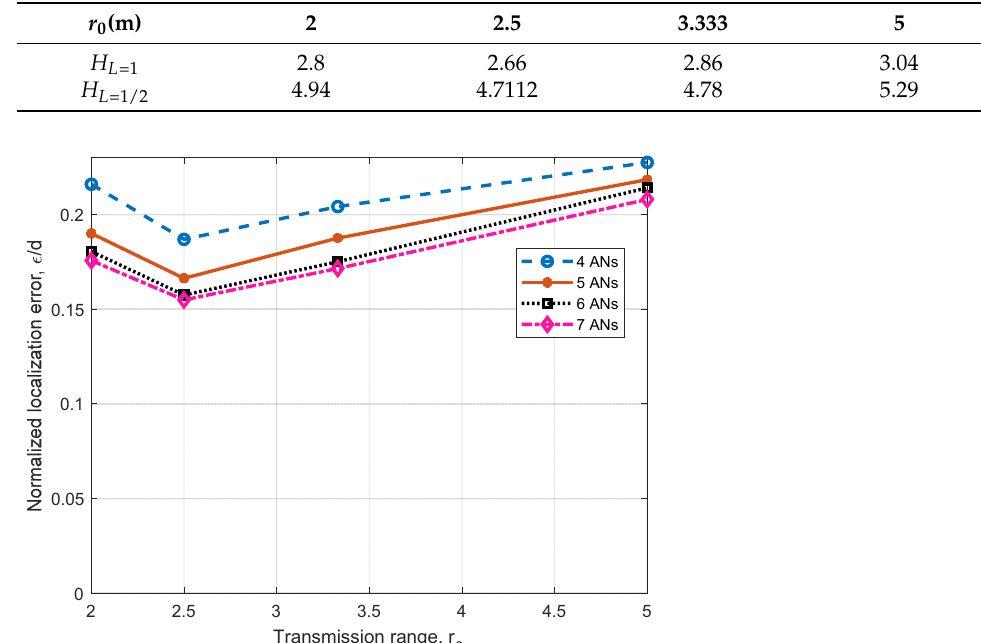
0 for four to seven ANs with L =